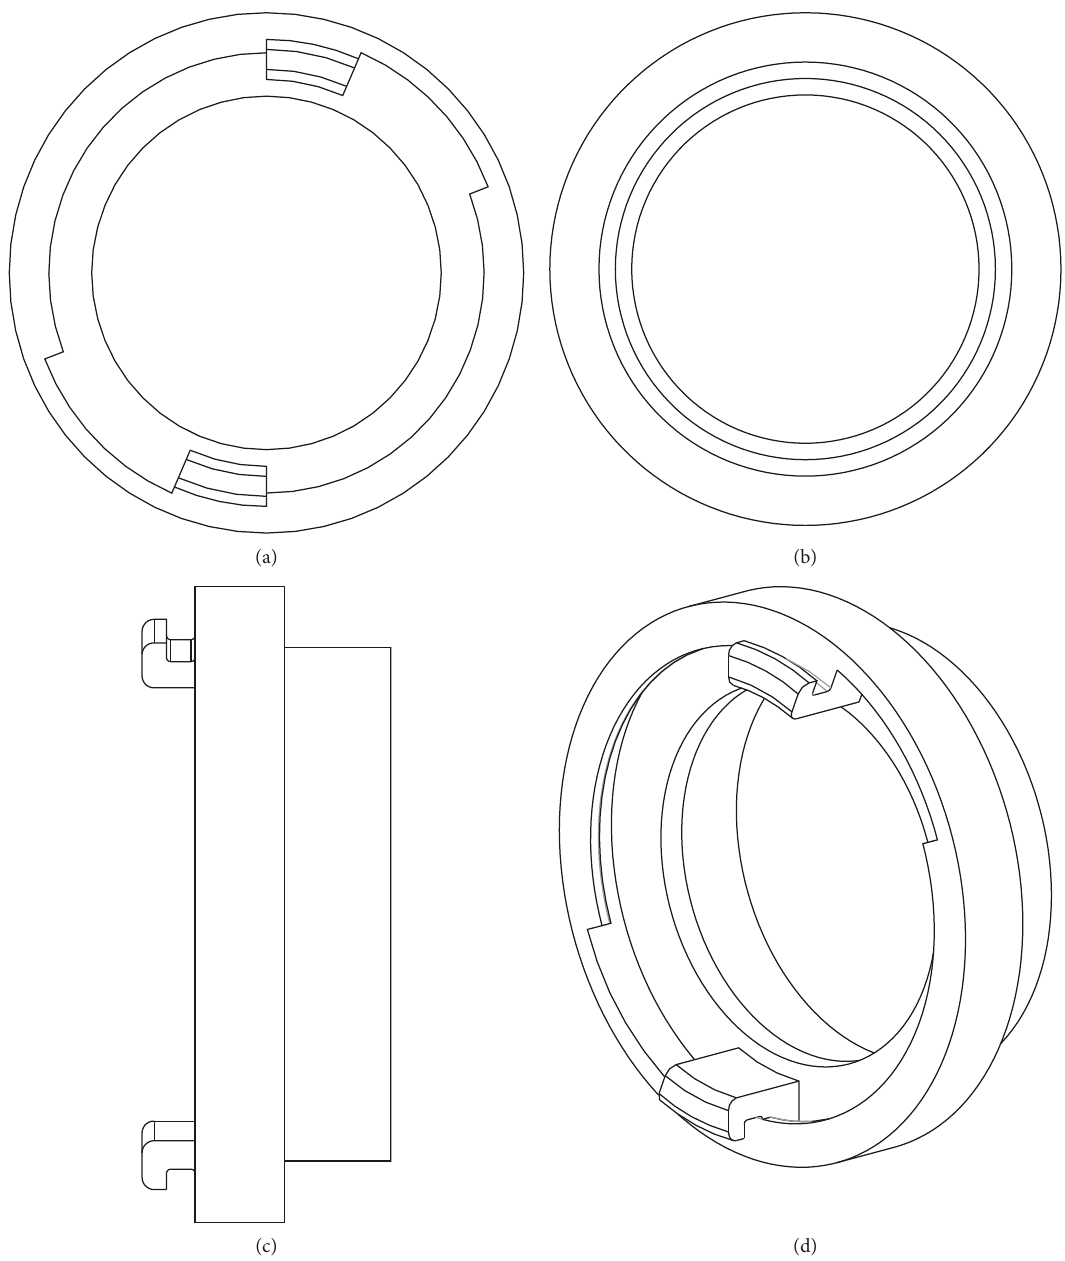
Figure 3: Different views of the joint. (a) Front view. (b) Back view. (c) Side view. (d) Axial